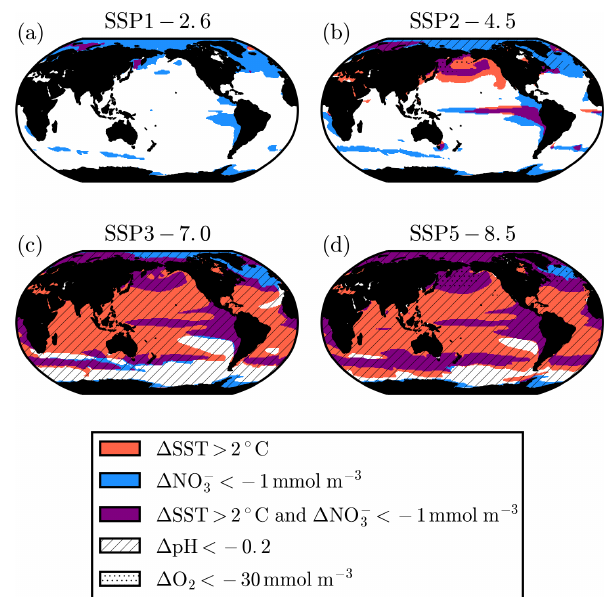
Figure 5. Compound upper-ocean impact drivers. Regions where projected CMIP6 sea surface warming exceeds 2 ◦ C, euphotic-zone (0–100m) NO − decline exceeds 1mmolm − 3 , surface ocean pH 3 decline exceeds 0.2, and subsurface (100–600m) dissolved O 2 con- centration decline exceeds 30mmolm − 3 in (a) SSP1-2.6, (b) SSP2- 4.5, (c) SSP3-7.0, and (d) SSP5-8.5. The exceedance of driver thresholds is determined from 2080 to 2099 anomalies relative to 1995–2014